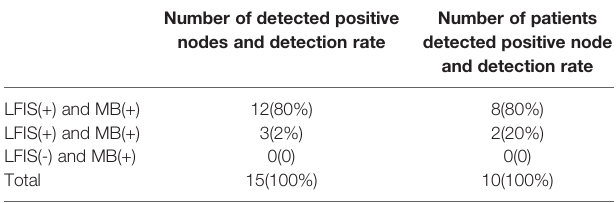
TABLE 3 | Metastatic SLNs and patients with metastatic SLNs detected by different methods. Number of detected positive nodes and detection